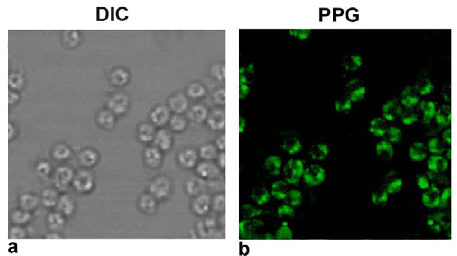
Figure 1. Immunolocalization of PPG in pure amastigotes derived from splenic tissue by confocal laser scanning microscopy. (a) DIC image (Differential interference contrast image) of purified amastigotes in confocal microscopy which is similar to that obtained by phase contrast microscopy but without the bright diffraction halo (b) Fluorescent image of purified amastigotes using anti-PPG antibody with secondary anti-rabbit FITC labeled IgG.